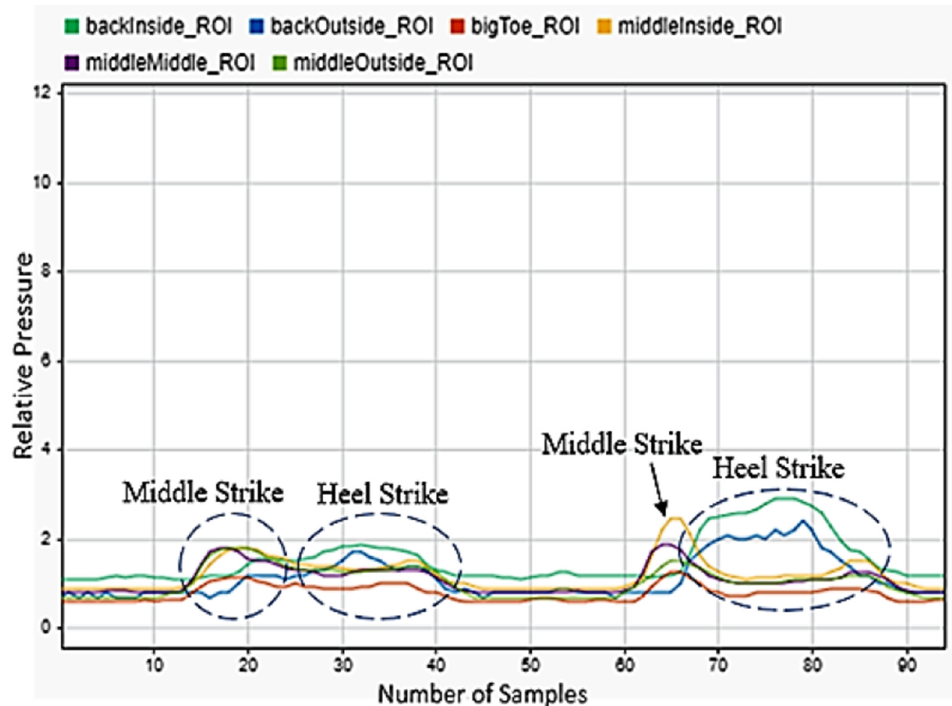
Figure 12. Pulling a cart sensor data for the left foot.